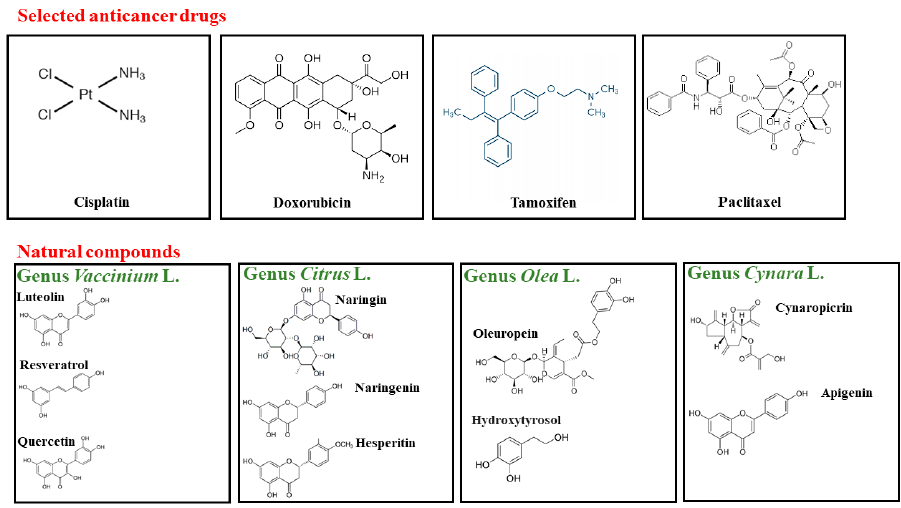
Figure 4. Chemical structure of selected anticancer drugs and natural compounds contained in the genera considered. genera